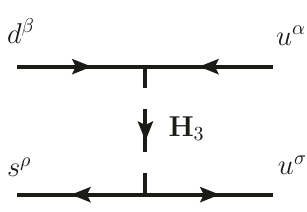
Figure 1 . Tree diagram for the K ! (cid:25)(cid:25) decays mediated by color-triplet diquark H 3 . which